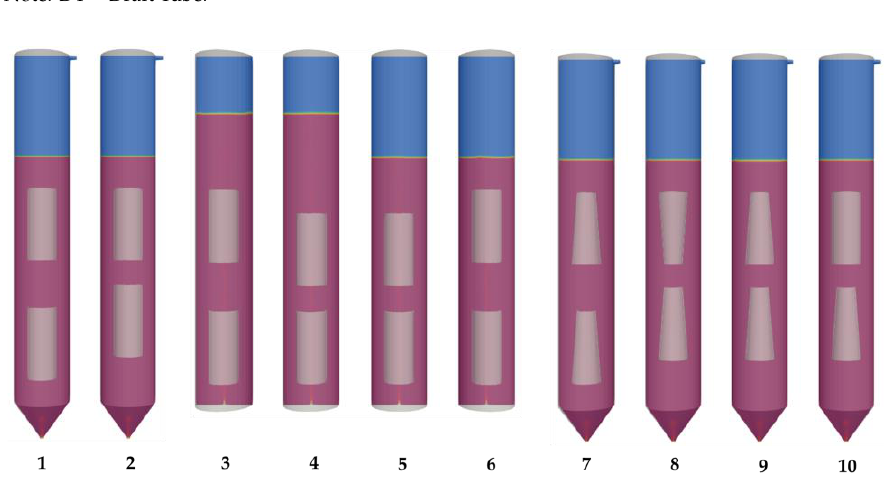
Figure 2. Geometries utilized in this study.